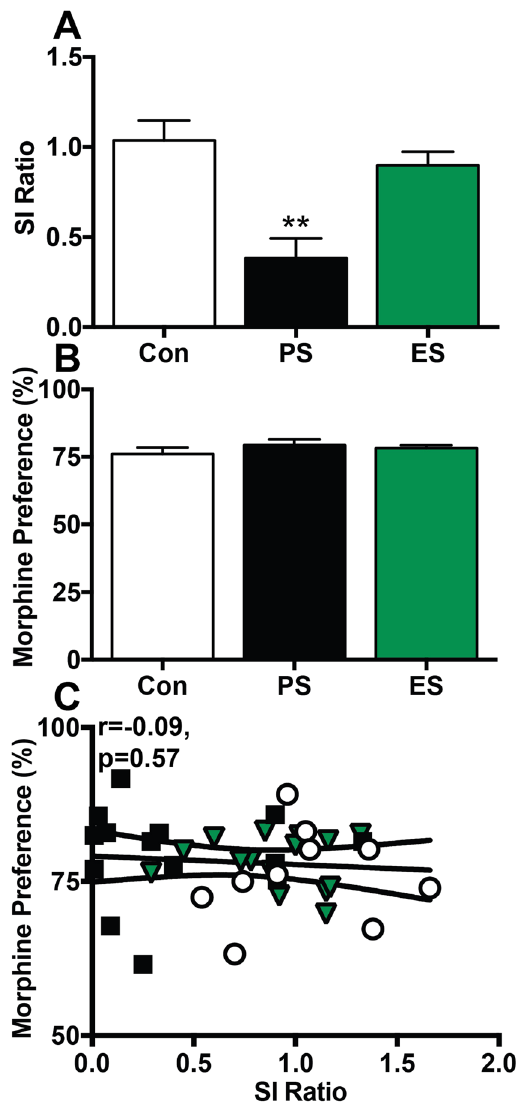
Figure 6. Voluntary morphine consumption is normalized two weeks following CSDS. ( A ) Social interaction (SI) ratio on post-defeat day 14 was significantly decreased in physical stress (PS) but not emotional stress (ES) mice. ( B ) PS and ES mice displayed similar preference for a morphine solution to control mice. ( C ) Morphine preference was not correlated with SI ratio. n = 9–12 mice/